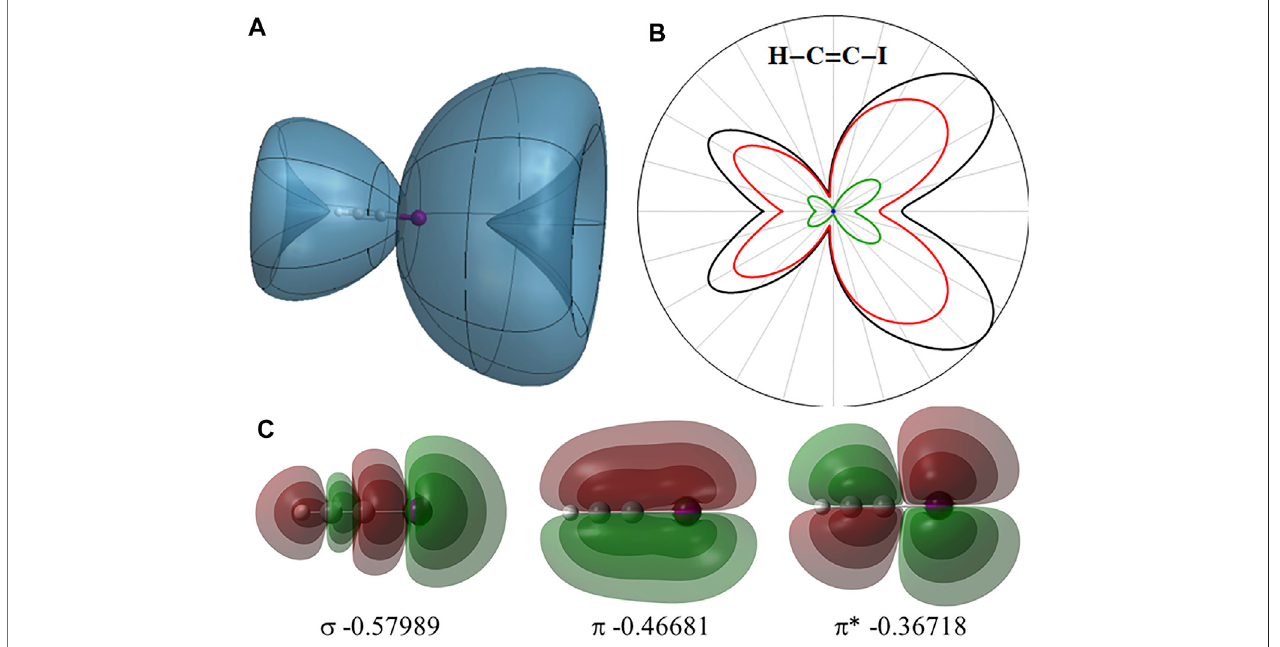
FIGURE 2 | (A) Angular dependence of the instantaneous ionization rate for neutral HCCI in static fi eld of 0.033 au. (B) 2-Dimensional slice showing the total ionizationrate(black)andcontributionsfromthe σ , π ,and π p orbitals(blue,greenandred,respectively). (C) Highestoccupied σ , π and π p orbitalsofHCCIandtheirorbital energies (in